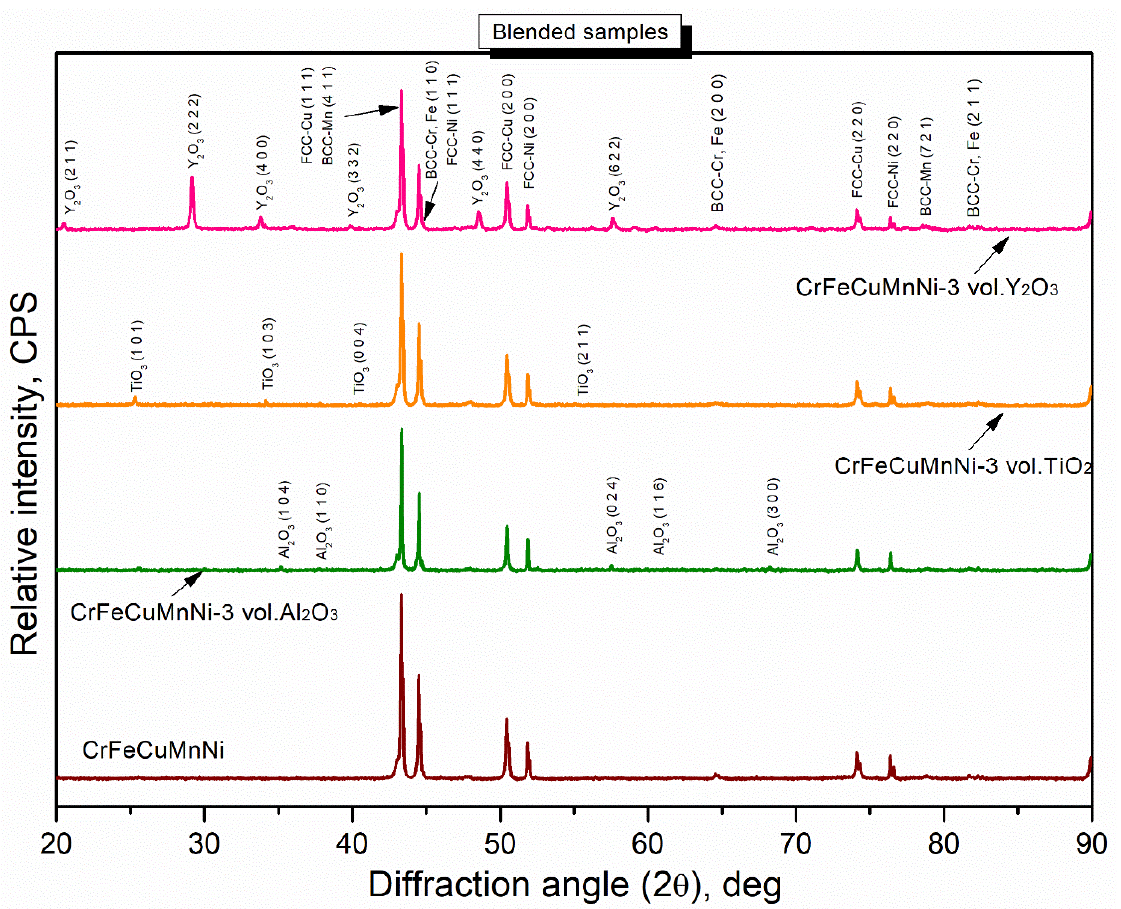
Figure 6 . X-ray diffraction peak profile of blended (0 h) oxide-dispersed strengthened high-entropy composites (ODS-HECs) of CrFeCuMnNi, CrFeCuMnNi-3 vol.% Al 2 O 3 , CrFeCuMnNi-3 vol.% TiO 2 , and CrFeCuMnNi-3 vol.% Y 2 O 3 . Table 2. Elemental parameters of developed ODS-HEACs of CrFeCuMnNi matrix